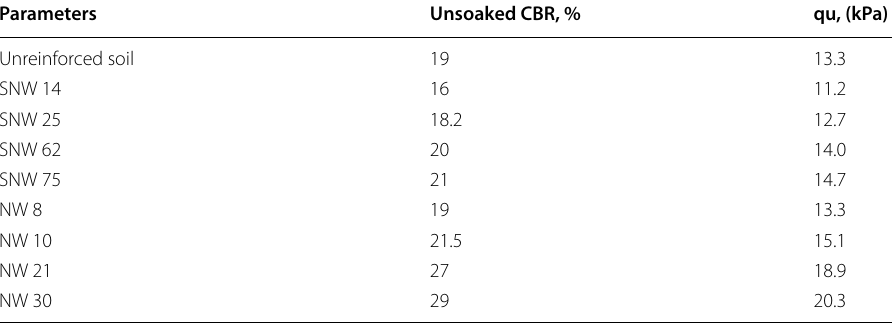
Table 5 Summary of tests results for geotextile’s with unreinforced soil